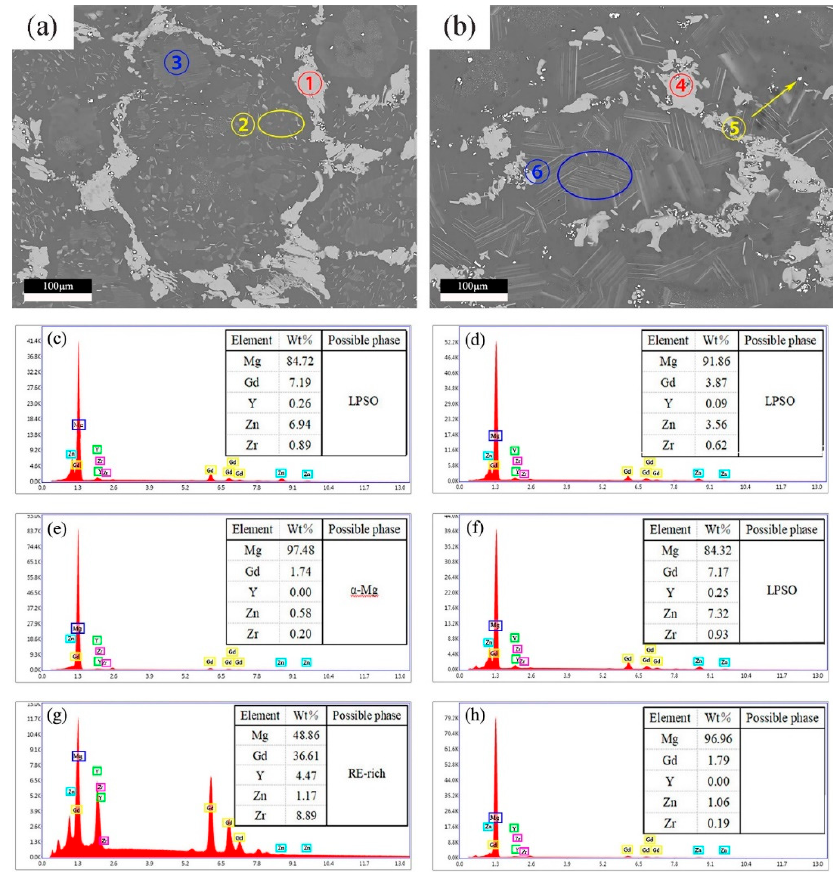
Figure 6. ( a ) SEM of 460 °C × 13 h, ( b ) SEM of 490 °C × 13 h ( c ) EDS results at ① , ( d ) EDS results at ② , ( e ) EDS results at ③ , ( f ) EDS results at ④ , ( g ) EDS results at ⑤ , ( h ) EDS results at ⑥ .